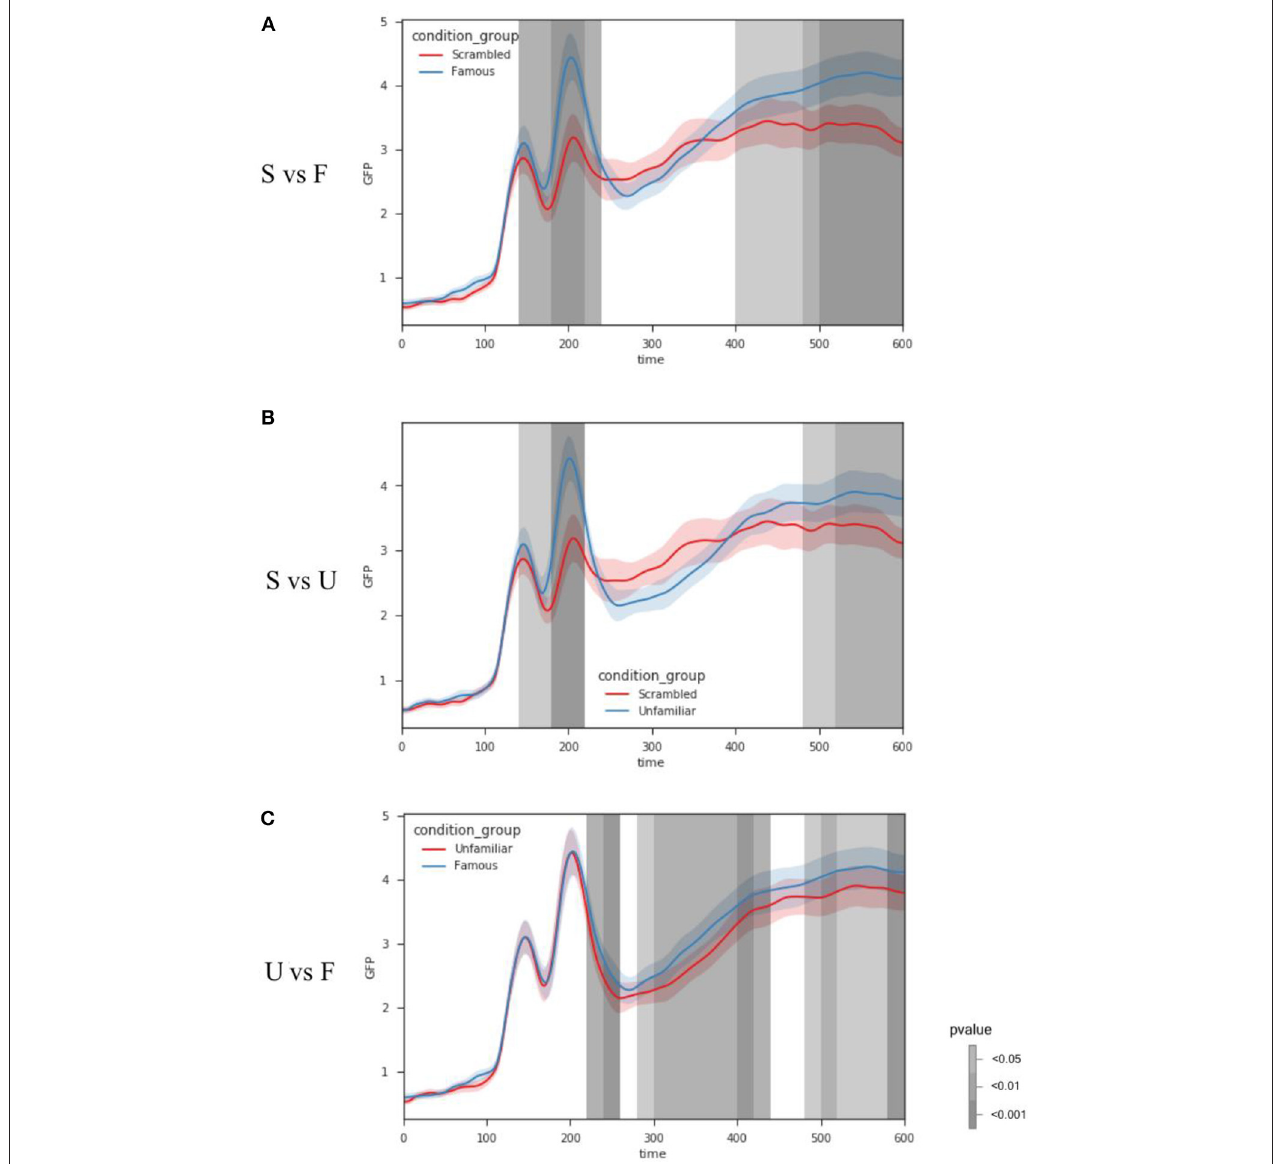
FIGURE 2 | Results of GFP analysis. Each color line represents the GFP of each condition. Condition labels are the same as Figure 1 . The shadow areas around each line depict the standard error of the mean. The grayscale vertical bar stands for the results of statistical analysis. Grayscale represents the significant levels, and location represents the latencies of significant effects. (A,B) The condition “Scrambled” (S) begins significantly different from the face perception conditions around 140ms. Differences are also significant at some later latencies. (C) For comparison between two face perception conditions, significant differences are observed starting around 220ms, later than those in comparisons between face and non-face conditions in (A,B) . Some later significant differences are also observed. Refer to main text for detailed